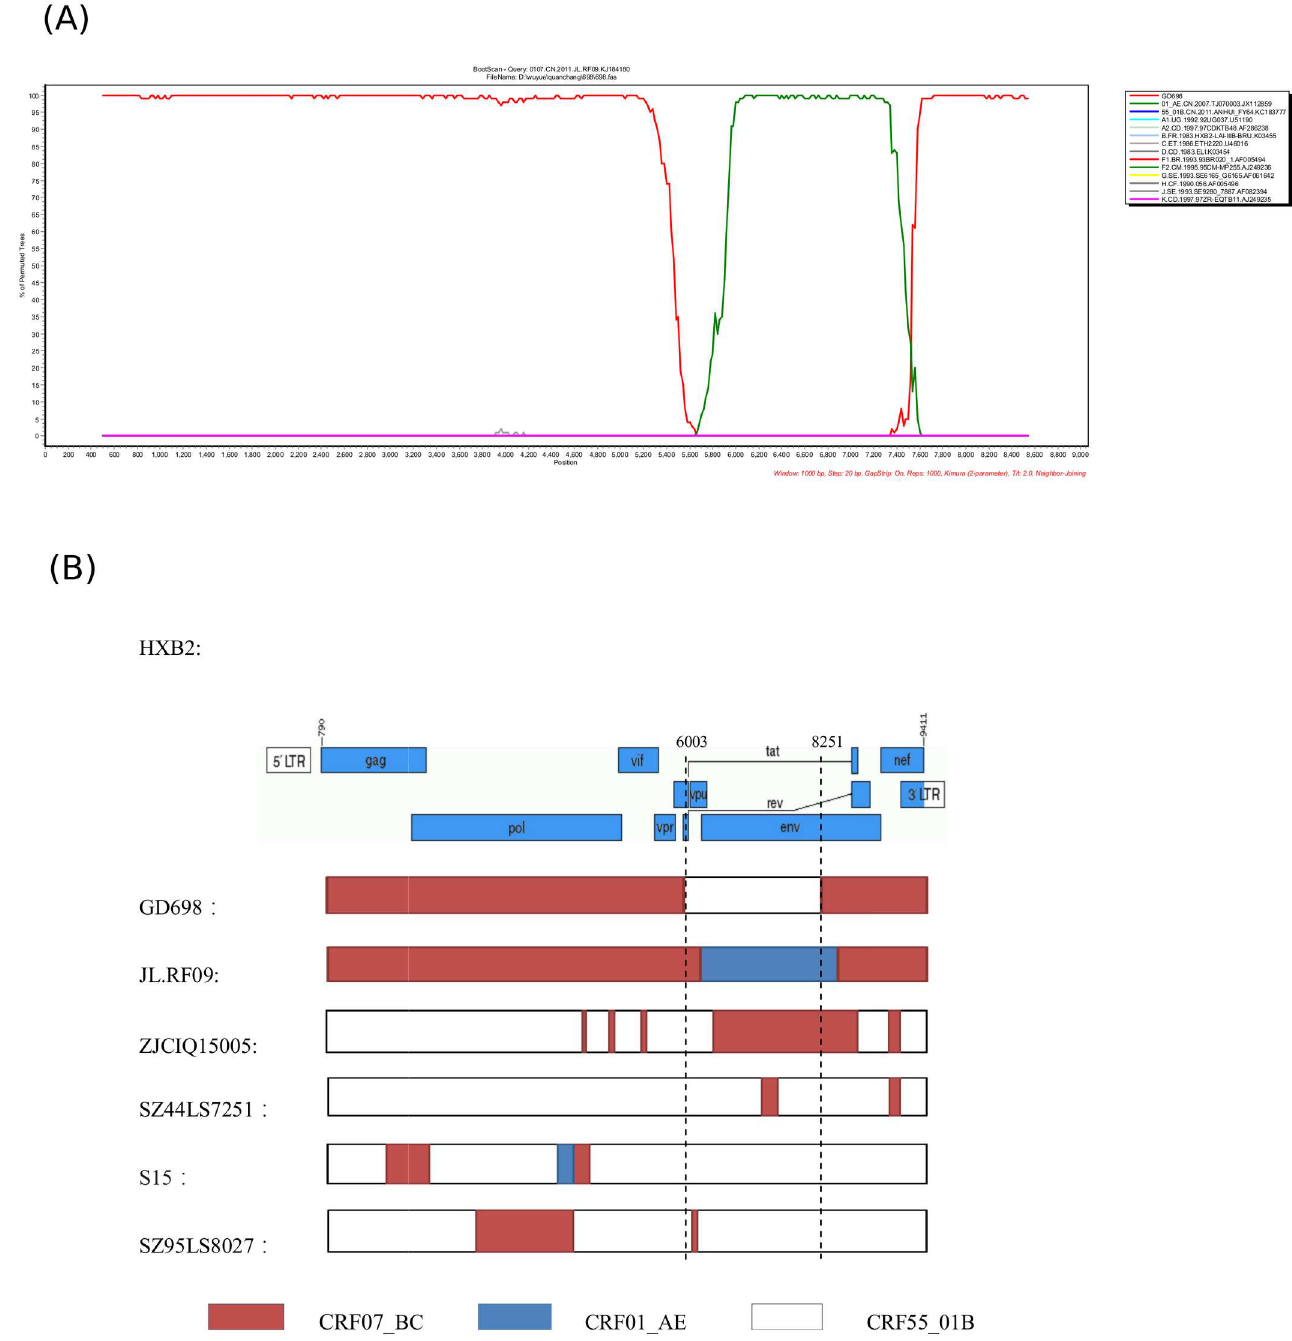
Fig 4. Comparison between GD698 and other recombinants of CRF07_BC/ CRF55_01B. (A) Bootscan analysisof JL.RF09 queriedagainst GD698. Bootscan analysiswas performed using SimPlot 3.5.1 software configuredwith 1000 bootstrapreplicates, a 1000bp window, and a step size of 50 bp. The x-axis shows all alignednt of the sequenceanalyzed.The y-axis shows the bootstrapvalue. (B) Diagramof the genomicstructure of CRF07_BC/CRF55_01B containing recombinants. HBX2 genomicregions are indicatedat the top of the plot as the reference structure. Breakpoint locationsare based on the HXB2 numbering. SimPlot and Genotyping were used to analyzeeach of the resulting genomesseparately; recombinant structures of each strain were determinedand listed. The red bar indicatesthe CRF07_BC regions, the blue bar indicatesthe CRF01_AE, and the white bar